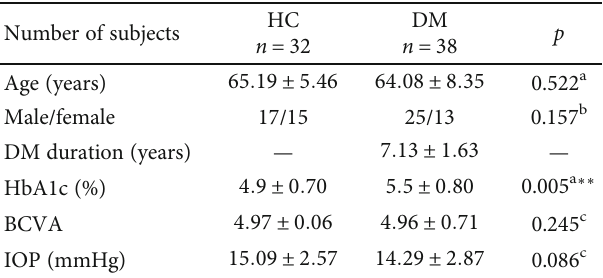
Figure 1: shows a fundus photo of the retina with the fi ve rings regions where the mf-ERG can detect the retinal function in the relevant area by extraction of signal in posterior retina. Table 1: Epidemiologic and disease characteristics of all participants in this